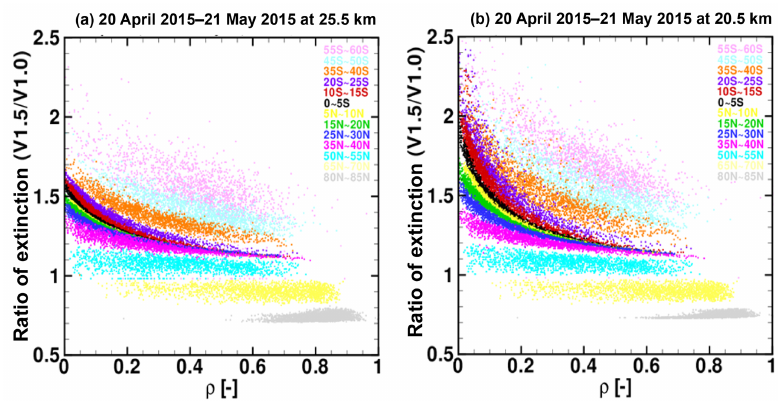
Figure 6. Scatterplots of extinction ratio (V1.5 / V1.0) as a function of effective reflectivity ( ρ ) for different latitude bins at 25.5km (a) and 20.5km (b) . The figure shows that the extinction ratios vary nonlinearly with the effective reflectivity, especially for reflectivity < 0 . 2. The shape of the function changes considerably with latitude and altitude. (From Chen et al., 2018.)